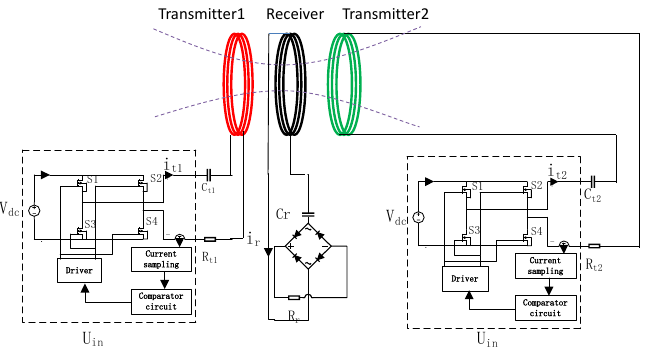
Figure 5. Dual transmitter circuit PT-symmetric radio energy transmission structure diagram. A schematic of the coupling between the three coils is shown in Figure 6, where M t 1 r denotes the mutual inductance between transmitter 1 and the receiving coil, M t 2 r denotes the mutual inductance between transmitter 2 and the receiving coil, and M t 1 t 2 and M t 2 t 1 denote the mutual inductance between the two transmitter coils. On the transmitting side, the flux excited by i t 1 crosses coil L r , and the amount of this flux can be expressed as Ψ t1r . The flux excited by i t 2 crosses coil L r and the amount of this flux can be expressed as Ψ t2r . “S” is the area of the monopole coil, “B” represents the flux density, and since the area of the three coils is the same, it is uniformly expressed as S. Ψ t1r can be expressed